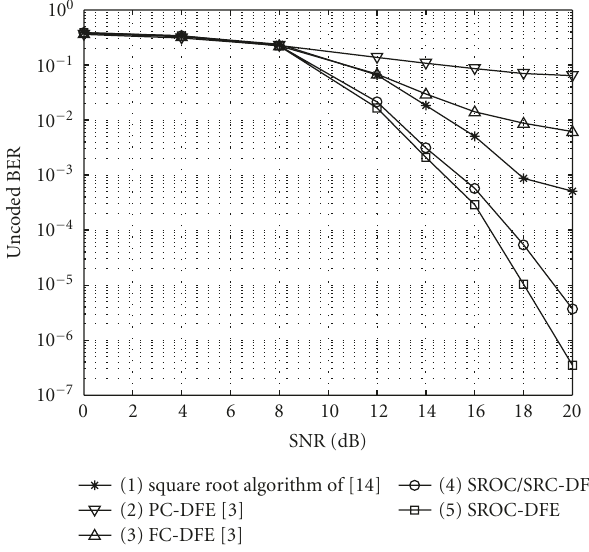
Figure 5: Uncoded BER curves of equalizers for a 4 × 4 system trained for 512 T s , and operating over a time-varying frequency- selective MIMO channel with a normalized Doppler frequency of 5 . 5 · 10 − 5 .